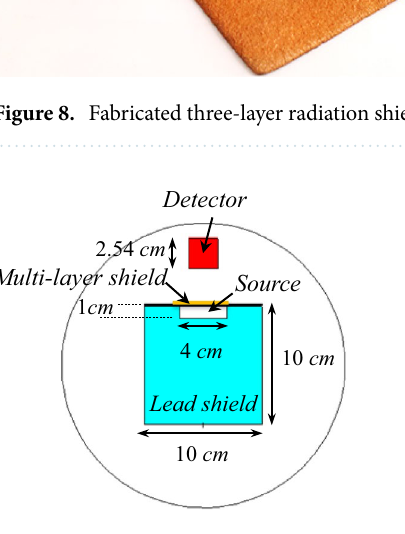
Figure 9. Configuration of the source, detector and shield in the MCNPX code.